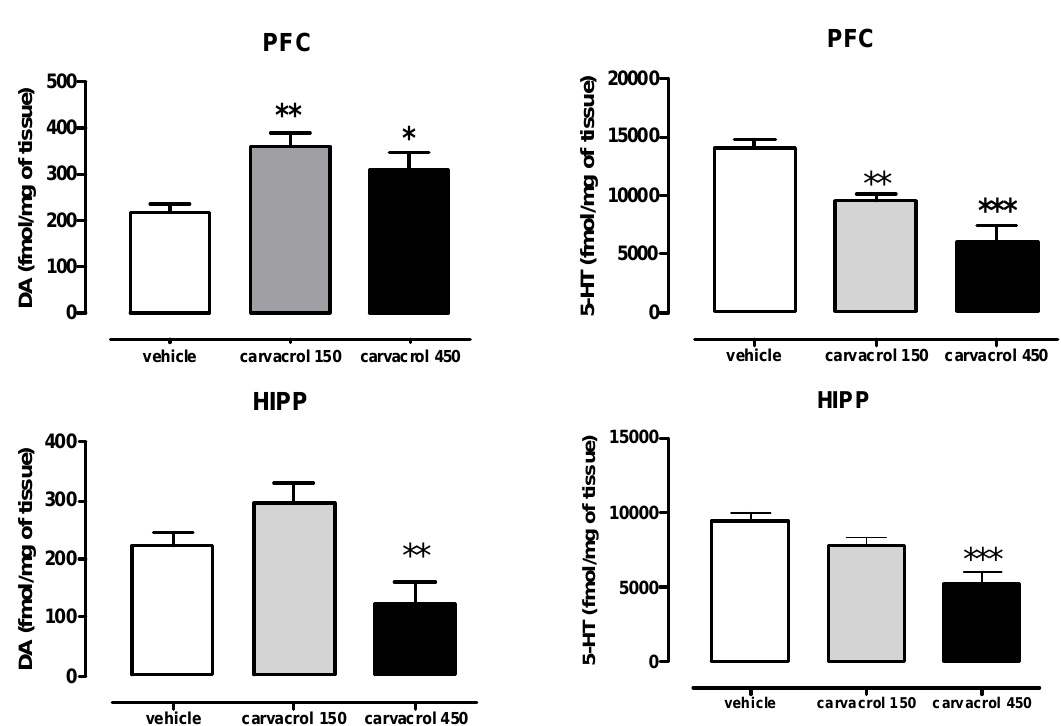
Figure 2. Measurement of DA and 5-HT content in PFC and HIPP of male Wistar rats orally treated with carvacrol (acute administration, 150 or 450 mg/kg) or vehicle (peanut oil, 1 mL/kg). Data were expressed as mean + S.E.M. ( n = 8, one-way Anova, followed by Tukey’s test, * P < 0.05, ** P < 0.01, *** P < 0.001).